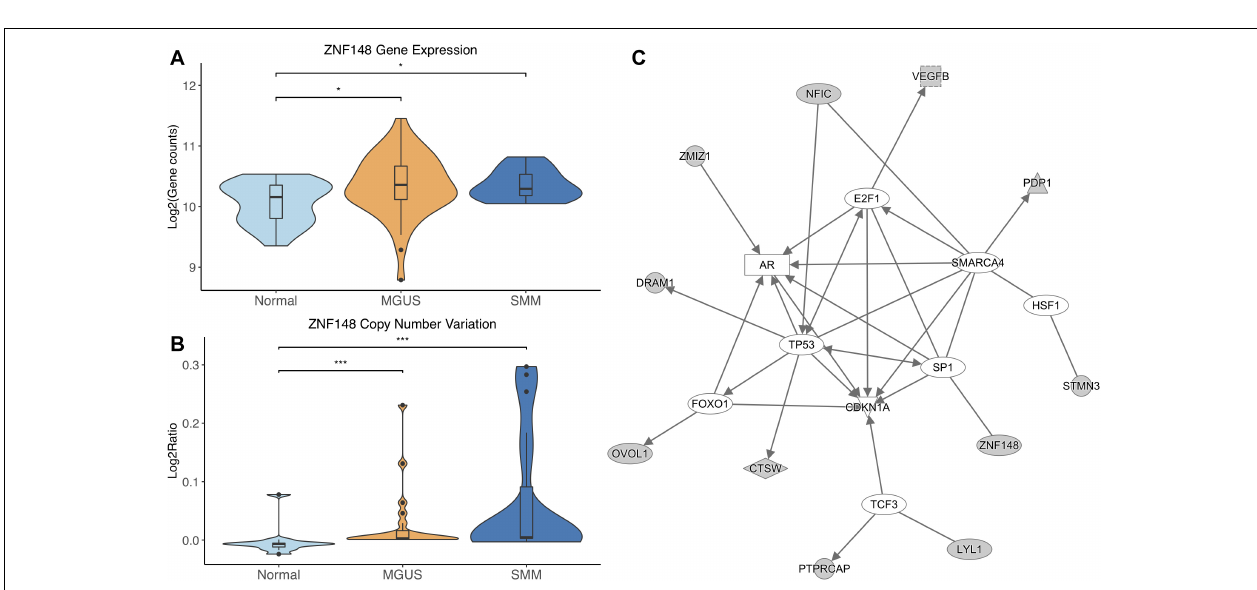
FIGURE 3 | (A) MAX expression across sample groups. Mann–Whitney tests between groups showed no significant difference. (B) Observations of MAX copy number. Mann–Whitney tests showed significant copy number variation between Normal and MGUS ( p = 1.17E-05) and between Normal and SMM ( p = 6.10E-04). (C) A predicted interaction network of MAX and its downstream targets. The gray nodes indicate genes from our module and the white nodes are gene interactions defined in IPA. Solid lines between nodes indicate a direct interaction supported by the Ingenuity Knowledge Base while the dashed line indicates an indirect interaction. Significance levels: ∗ p ≤ 0.05; ∗∗ p ≤ 0.01; ∗∗∗ p ≤ 0.001.